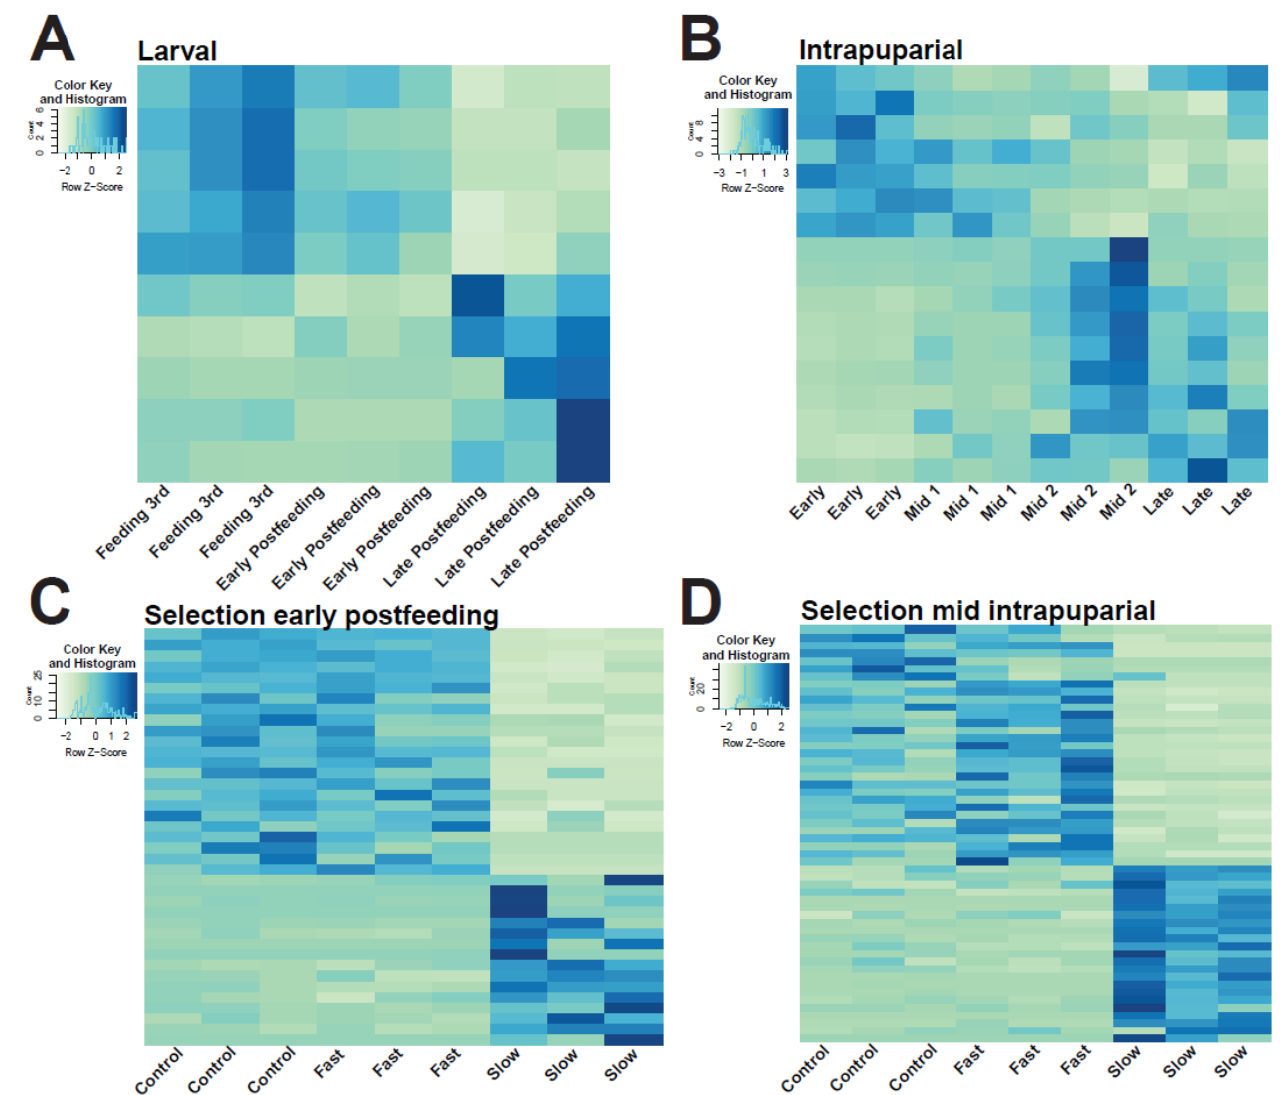
Figure 2. Heatmaps of significantly differentially expressed (SDE) miRNAs from DESeq2 Analyses. ( A ) SDE miRNA across larval development in wild-type C. macellaria . Names, fold-change, and p -values can be found in Table S4. Heatmap with miRNA labels can be found in Figure S30. ( B ) SDE miRNA across intrapuparial development in wild-type C. macellaria . Names, fold-change, and p - values can be found in Table S5. Heatmap with miRNA labels can be found in Figure S31. ( C ) SDE miRNA across development time selected early postfeeding larval samples of C. macellaria . Names, fold-change, and p -values can be found in Table S6. Heatmap with miRNA labels can be found in Figure S32 ( D ) SDE miRNA across developmental time in terms of mid-intrapuparial samples of C. macellaria . Names, fold-change, and p -values can be found in Table S6. Heatmap with miRNA labels can be found in Figure S33. Darker colors indicate higher levels of expression.